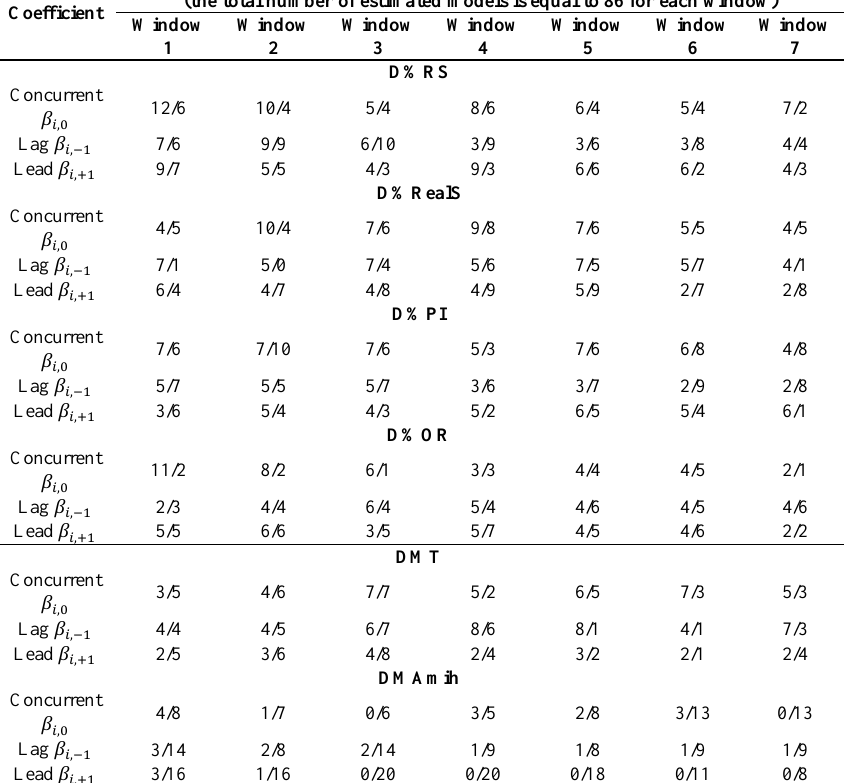
Table 2. The rolling-window results of testing for market-wide commonality in liquidity on the Warsaw Stock